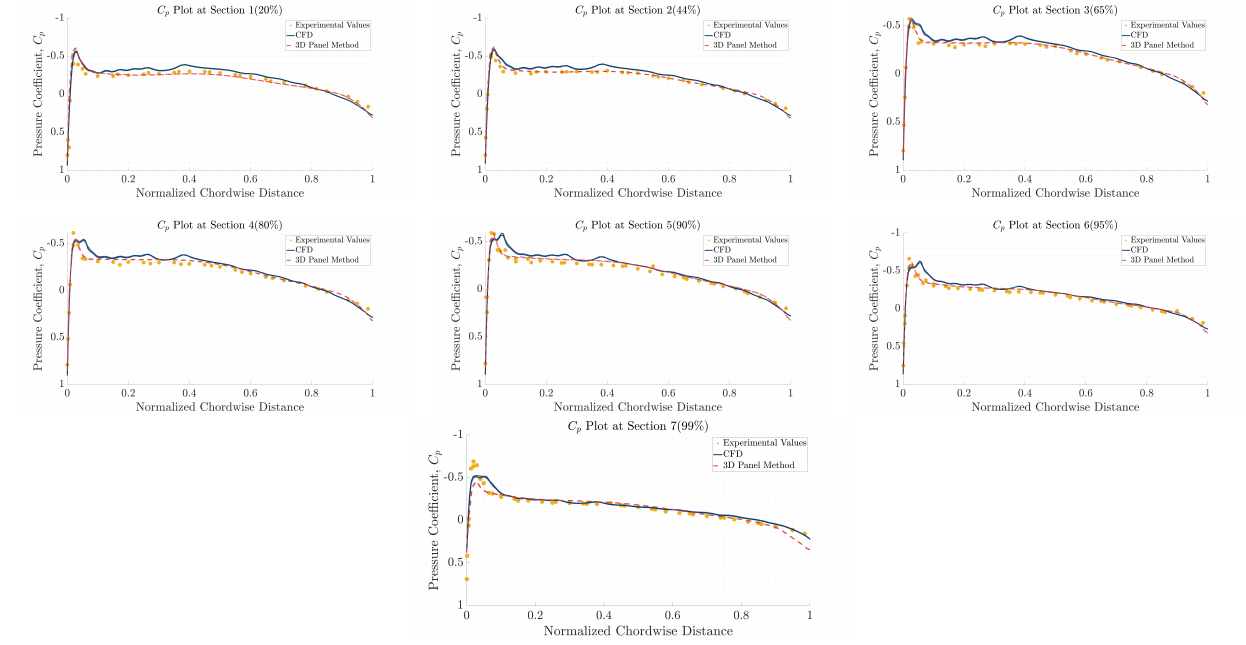
Figure A4. Pressure coefficient comparison at each spanwise